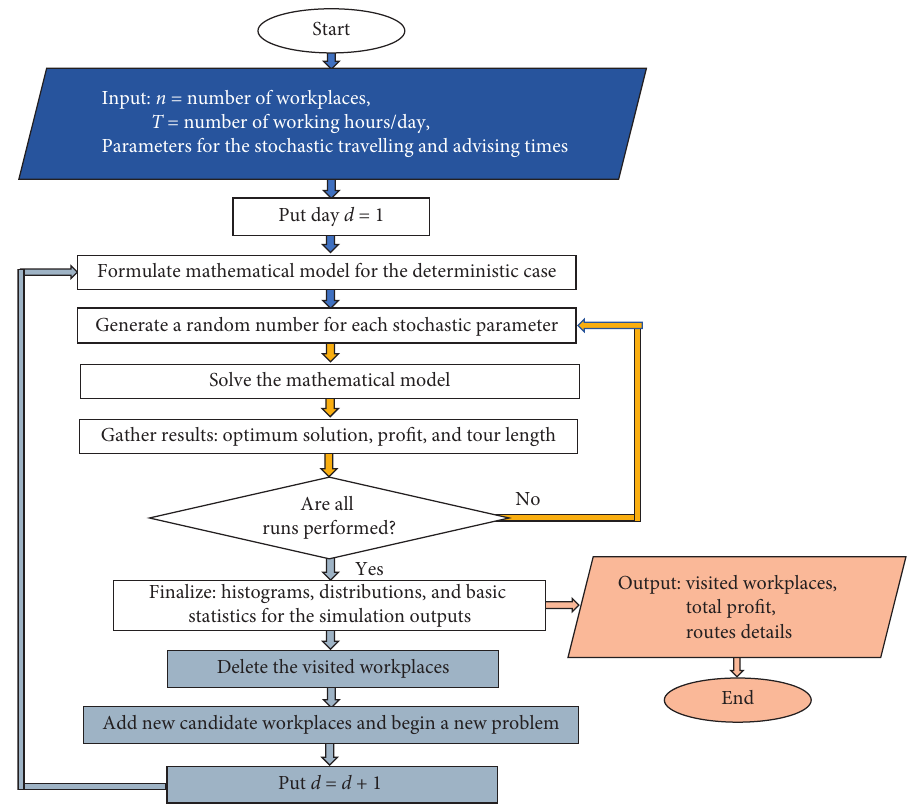
Figure 1: Steps of the simulation procedure of the stochastic